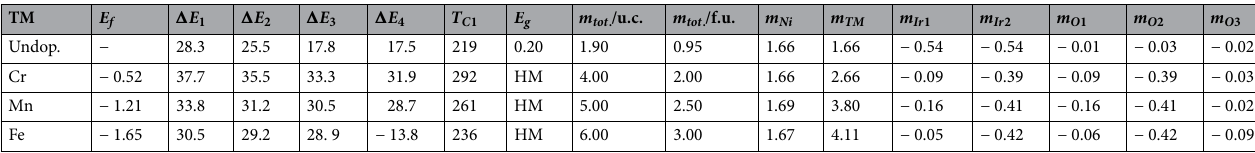
Table 1. Calculated formation energy ( E f ) in eV, magnetic energy differences: (cid:31) E 1 = E FM − E FiM − I , (cid:31) E 2 = E FM − E FiM − II , (cid:31) E 3 = E FM − E FiM − III , and (cid:31) E 4 = E FM − E FiM − IV in meV, FiM ordering temperature ( T C 1 ) in K, and energy band gap ( E g ) in eV for Lu 2 Ni 0.5 TM 0.5 IrO 6 (TM = Cr, Mn, and Fe) double perovskite oxides. The “−” and “ + ” signs in E f and (cid:31) E show that doped crystal structure and FiM spin ordering are energetically stable, respectively. Moreover, “ HM” in the E g column represents the half-metallic nature of the system along with total spin moments per unit cell ( m tot . /u.c.) as well as per formula unit ( m tot . /f.u.) and partial spin moments on Ni ( m Ni ), TM ( m TM ), Ir ( m Ir ), and O ( m O ) ions.